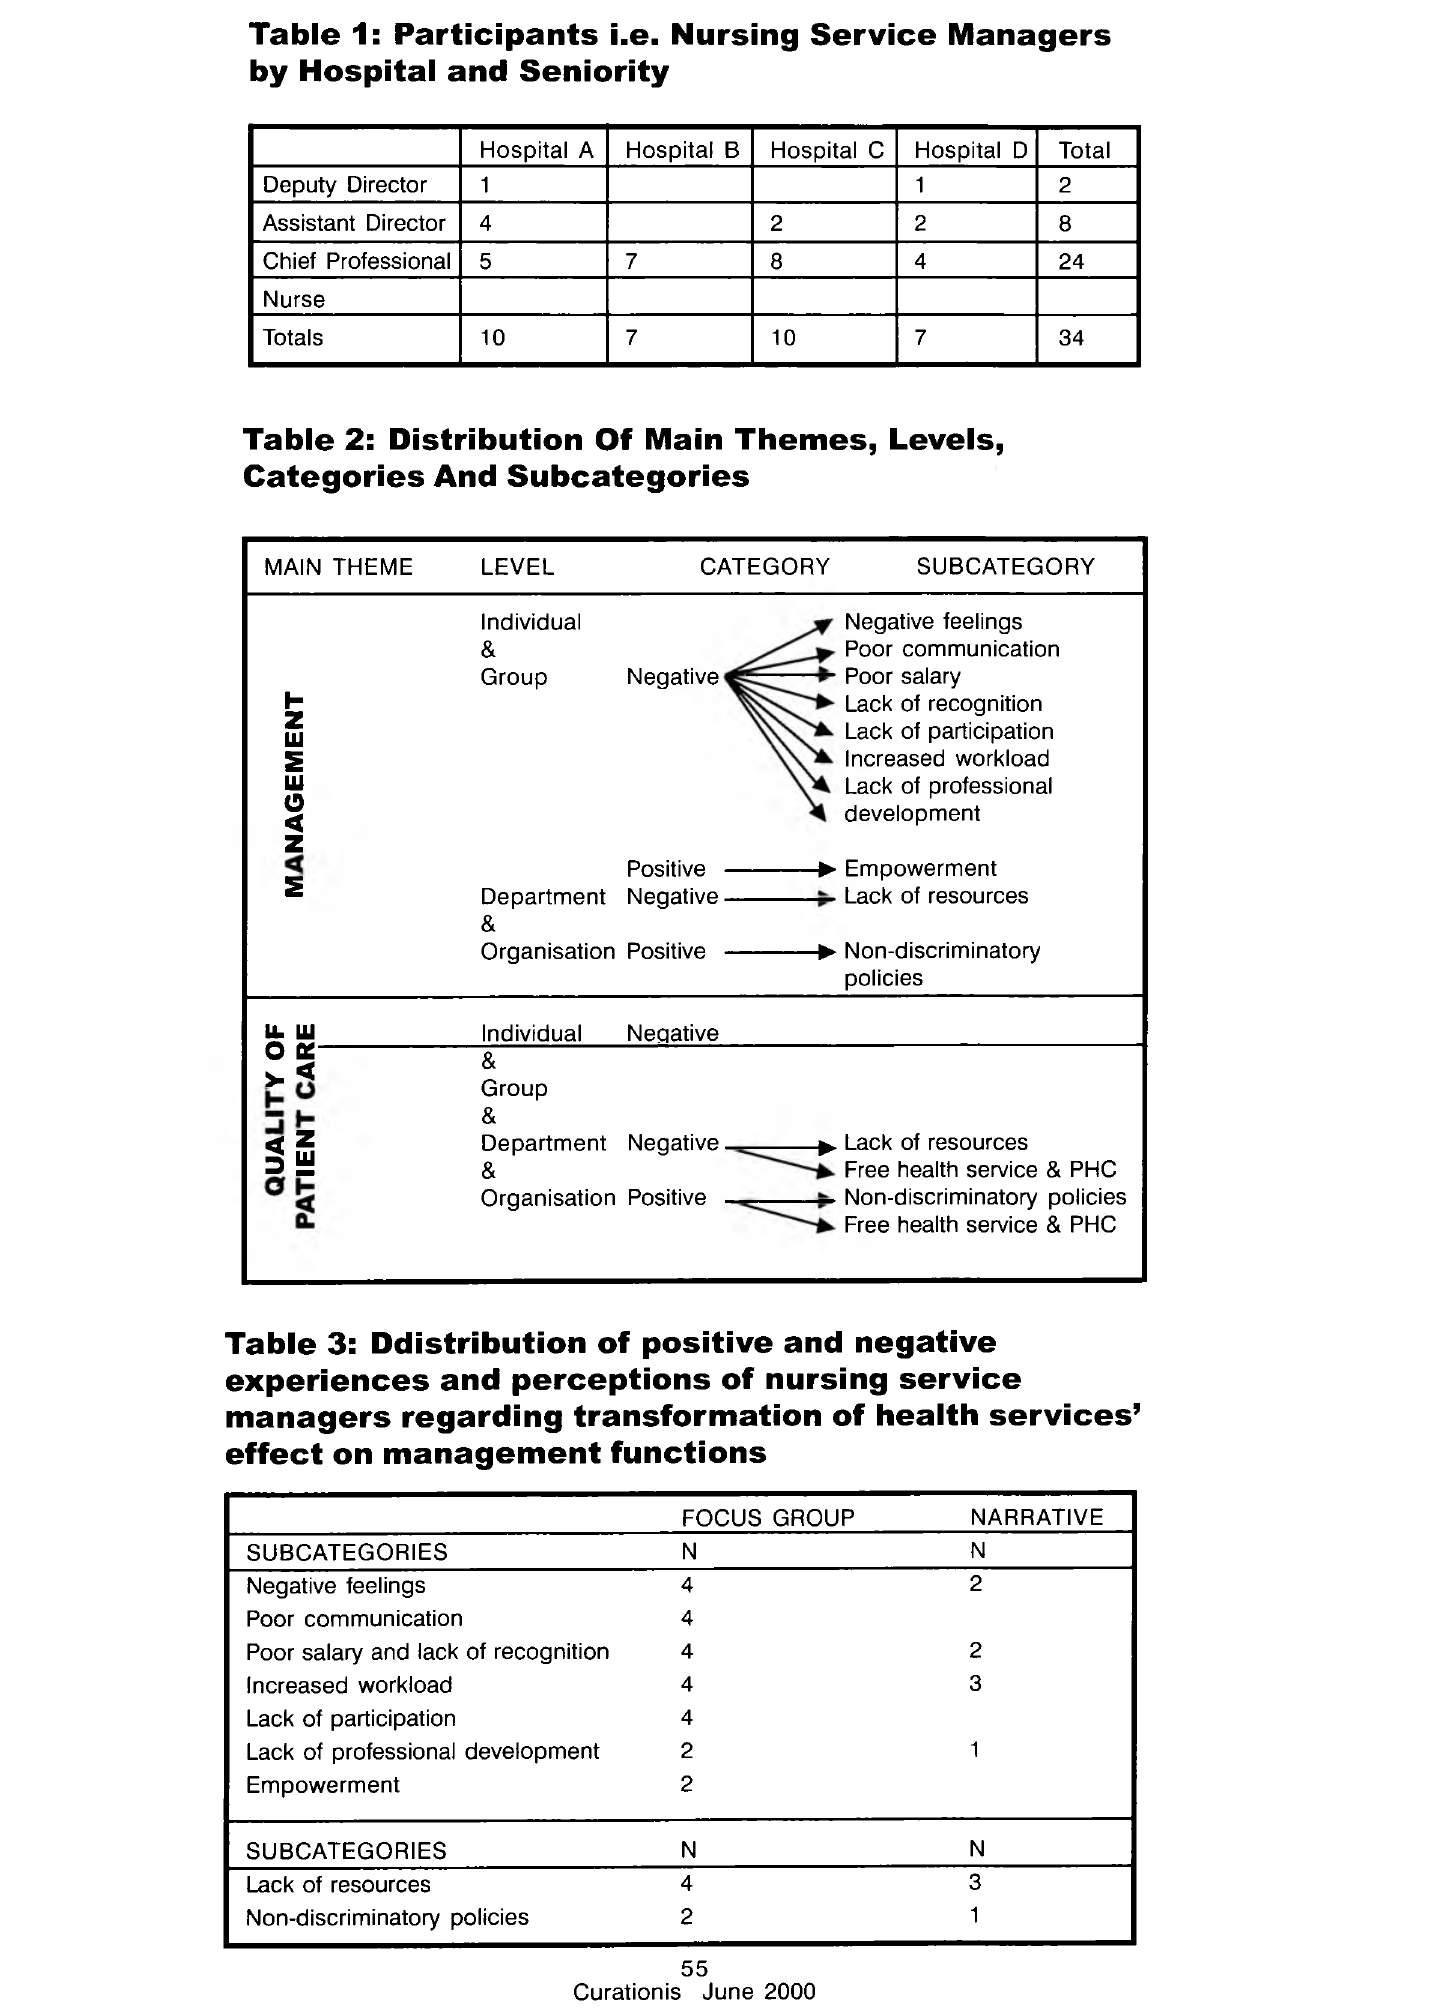
Tab le 1: P artic ip a n ts i.e. Nursing S ervice M anagers by H ospital and S en iority